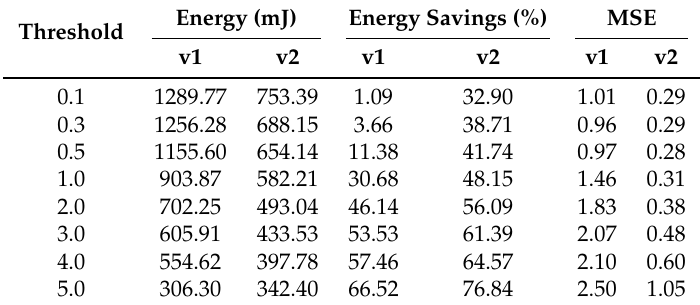
Table 4. ACxSIMv1 and ACxSIMv2